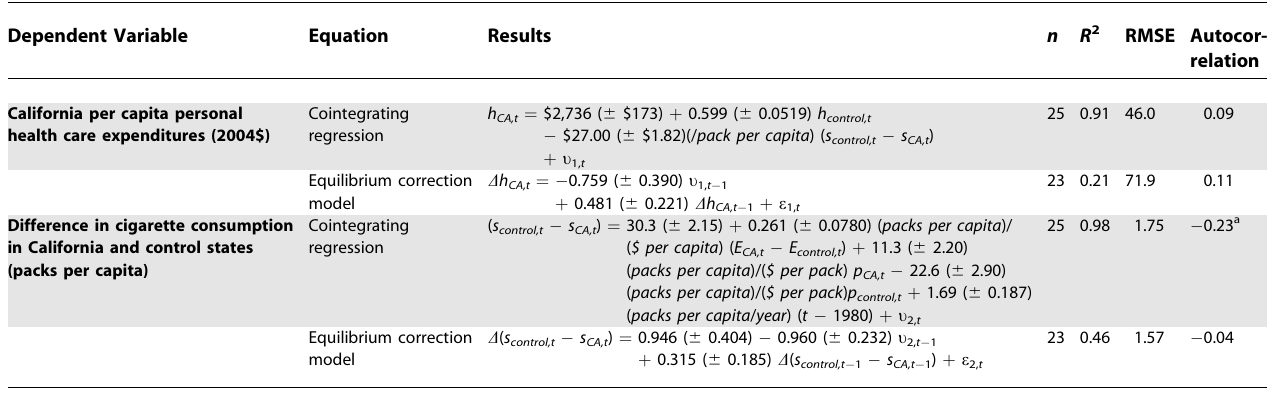
Table 1. Estimated California Personal Health Expenditure and Per Capita Cigarette Consumption Dependent Variable